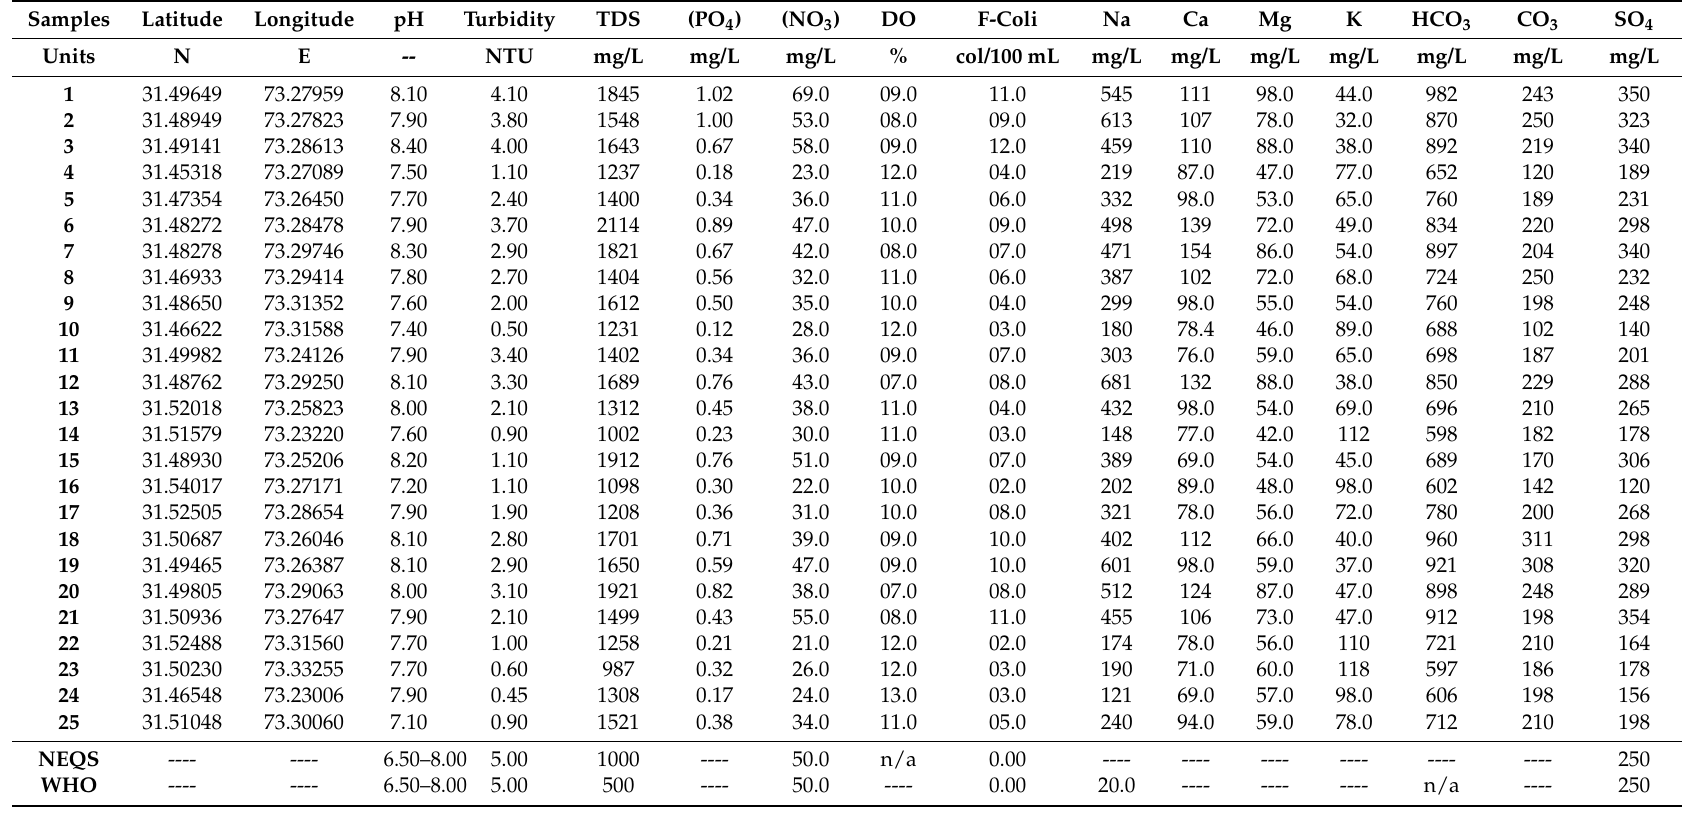
Table 2. Physico-chemical parameter analysis of groundwater for water quality and irrigation